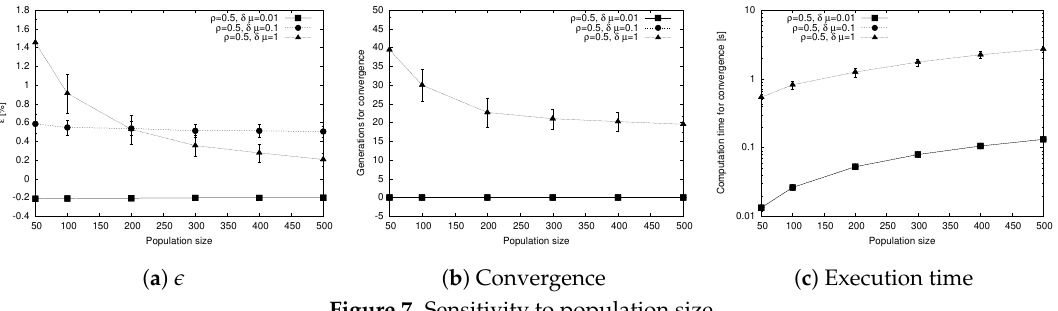
Figure 7. Sensitivity to population